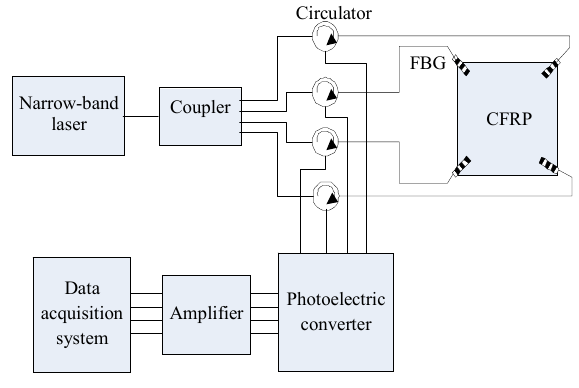
Fig. 2 FBG demodulation